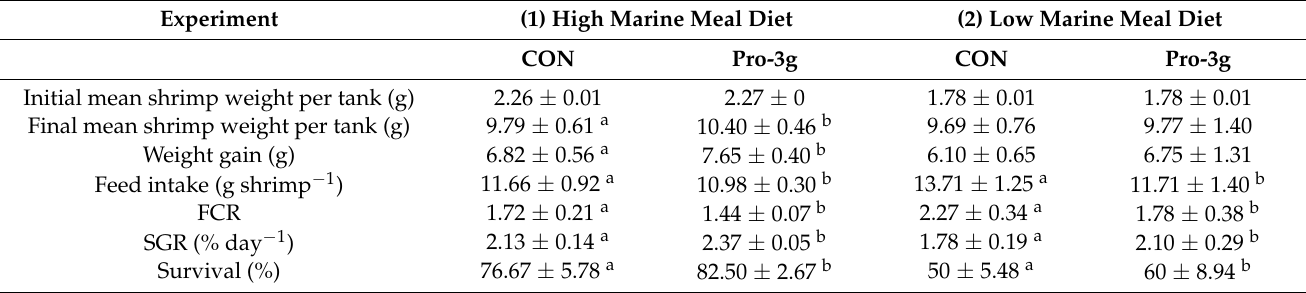
Table 2. Growth performance of shrimp after 8 weeks of feeding the experimental diets with or without the supplementation of a multi-species probiotic at 3 g/kg feed. Values are means ± standard deviation.